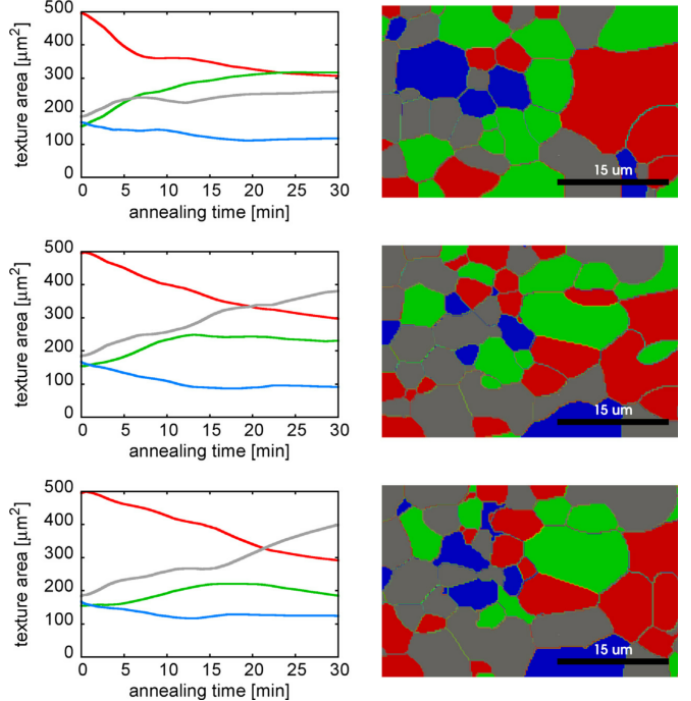
Figure 13. Texture evolutions by recrystallization for different limited mobility of twin boundaries. From top: the twin mobility is reduced by a factor 0.5, 0.1, and 0.001 [111].